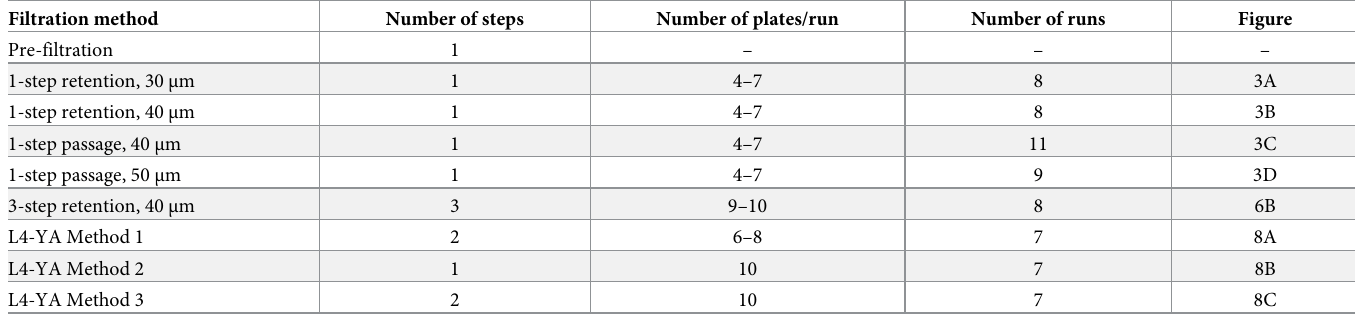
Table 1. Filtration protocols, number of filtration runs, and figures in which the associated data appear. Filtration method Number of steps Number of plates/run Number of runs Pre-filtration –